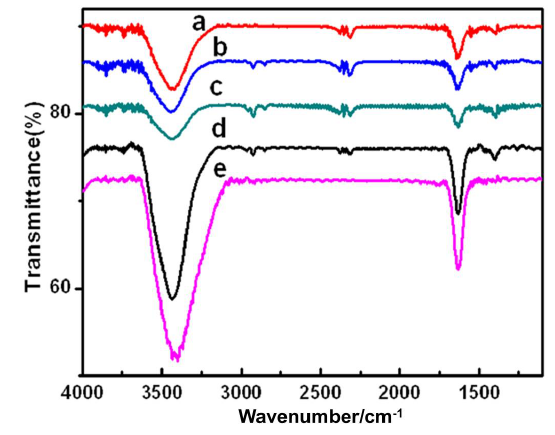
Figure 3. FTIR spectra of TiO , (b): FeP-TiO TiO 2